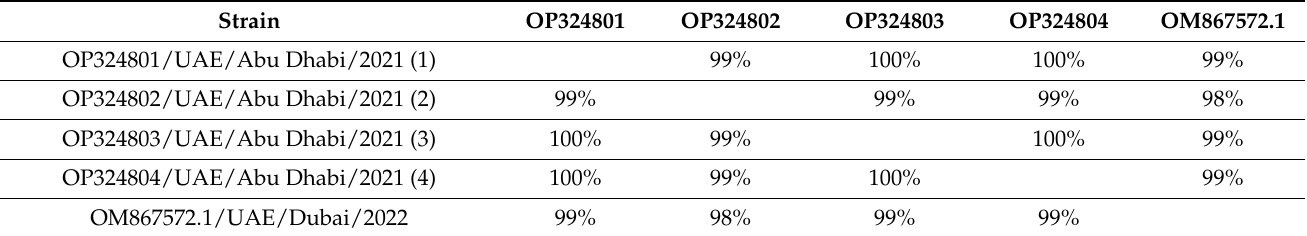
Table 4. Estimation of pairwise identity between PPRV F gene of this study strains and the newly published sequence from Barberry sheep (OM867572.1/UAE/Dubai/2022). Numbers in brackets are PPRV UAE 2021